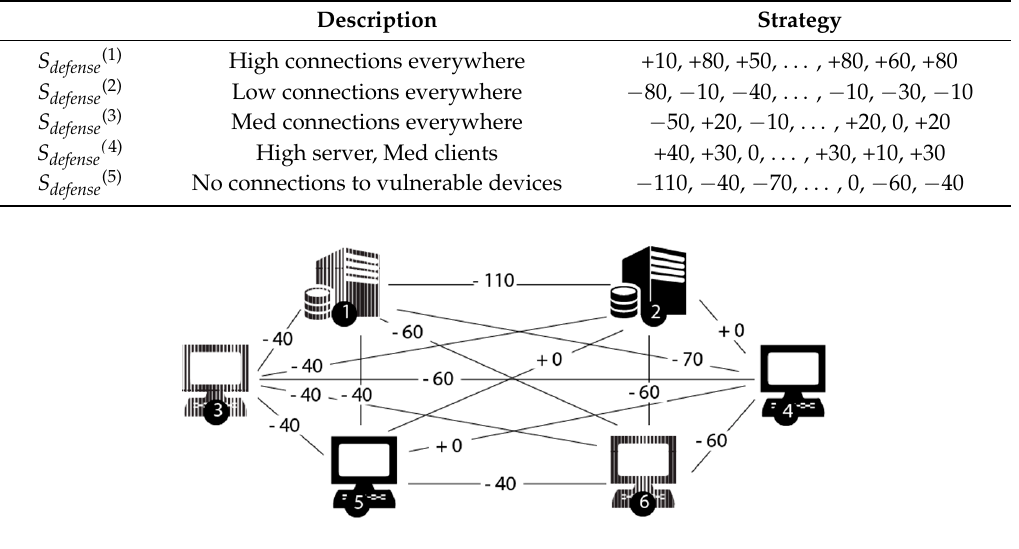
Figure 7. Defense Strategy 5.